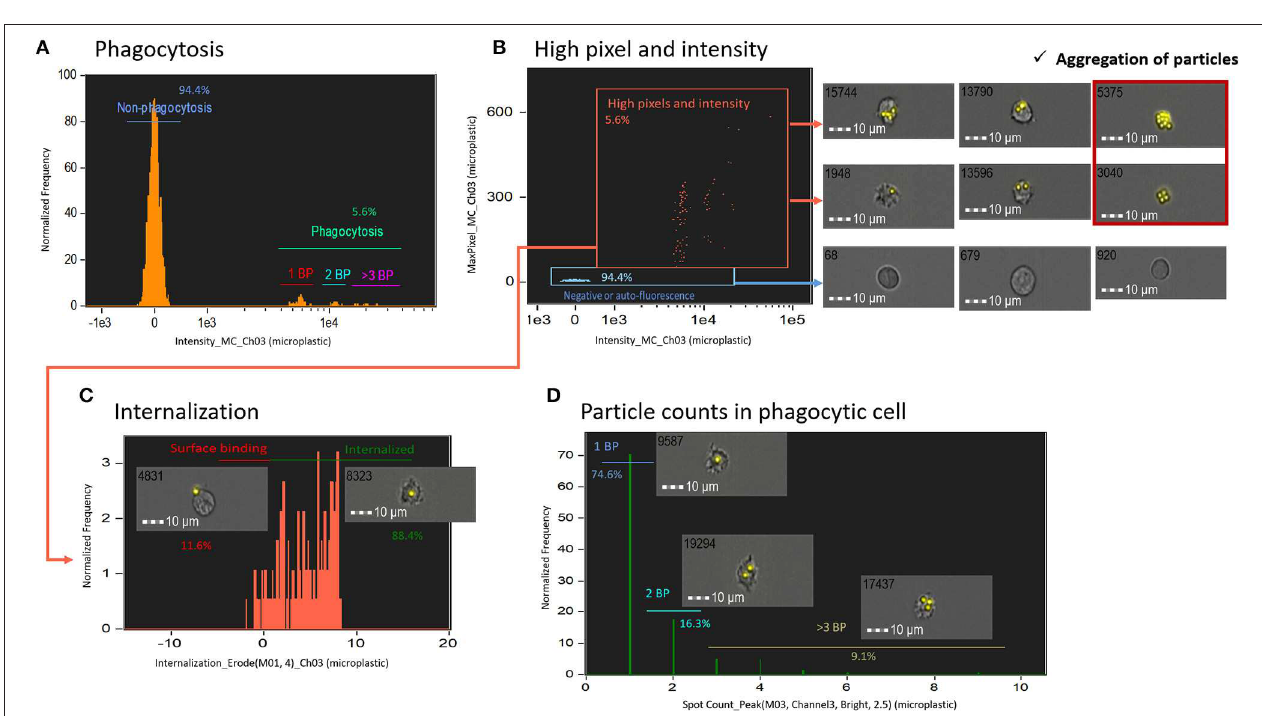
FIGURE 3 | Measurement of phagocytosis using non-degradable fluorescent particles (microplastics). (A) A histogram of fluorescent microplastic intensity in live cells. (B) To exclude auto-fluorescence and find the best images, images with more pixels and high intensity were gated. Errors may occur in conventional FC due to aggregation of microplastics. (C) Internalized cells were gated using internalization score. (D) Cells with internalized particles were plotted in a histogram of spot count, which shows the number of particles. All cell images were captured with 40 × objective. Scale bar = 10 µ m. BP, bio-particle.